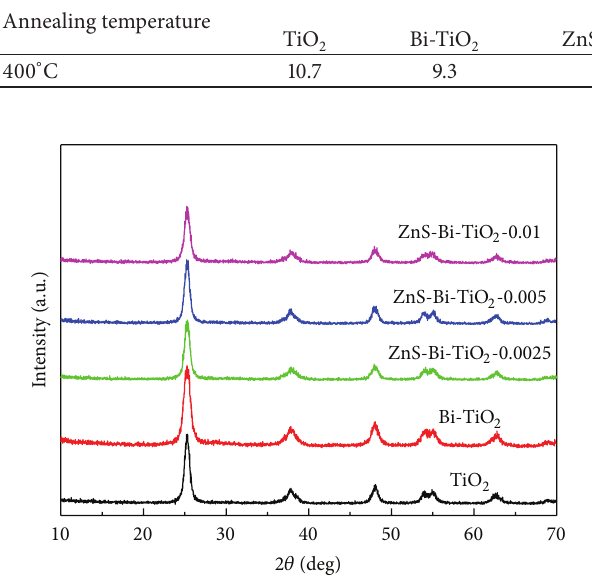
Figure 1: XRD patterns of TiO 2 , Bi-TiO 2 , and ZnS-Bi-TiO 2 - 𝑥